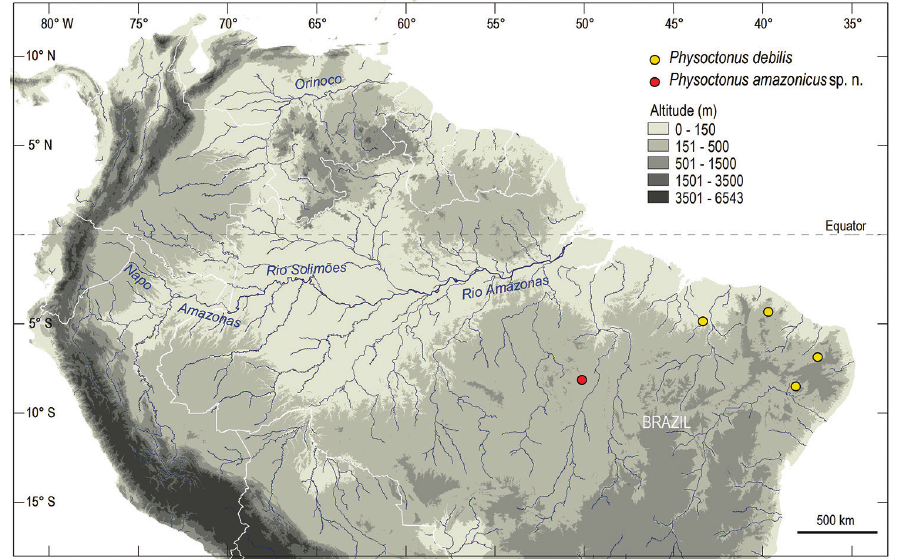
Figure 3. Map of northern South America, showing only the locations in north-east Brazil from where P. debilis was studied, and the type locality of the new